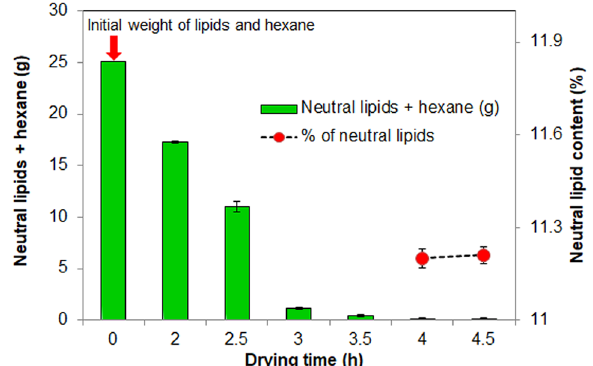
Figure 4. BTPSD based drying of hexane containing neutral lipids extracted from C. vulgaris strain.